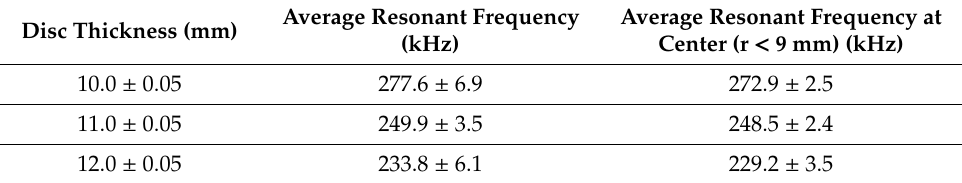
Figure 15. ( a ) C-Scan-normalized amplitude image of the three steel discs and ( b ) C-Scan image of the FFT center frequency. The colored bar in the second case represents the frequency in kHz. Table 5. Pulse-echo resonant frequencies at three discs in Figure 14.